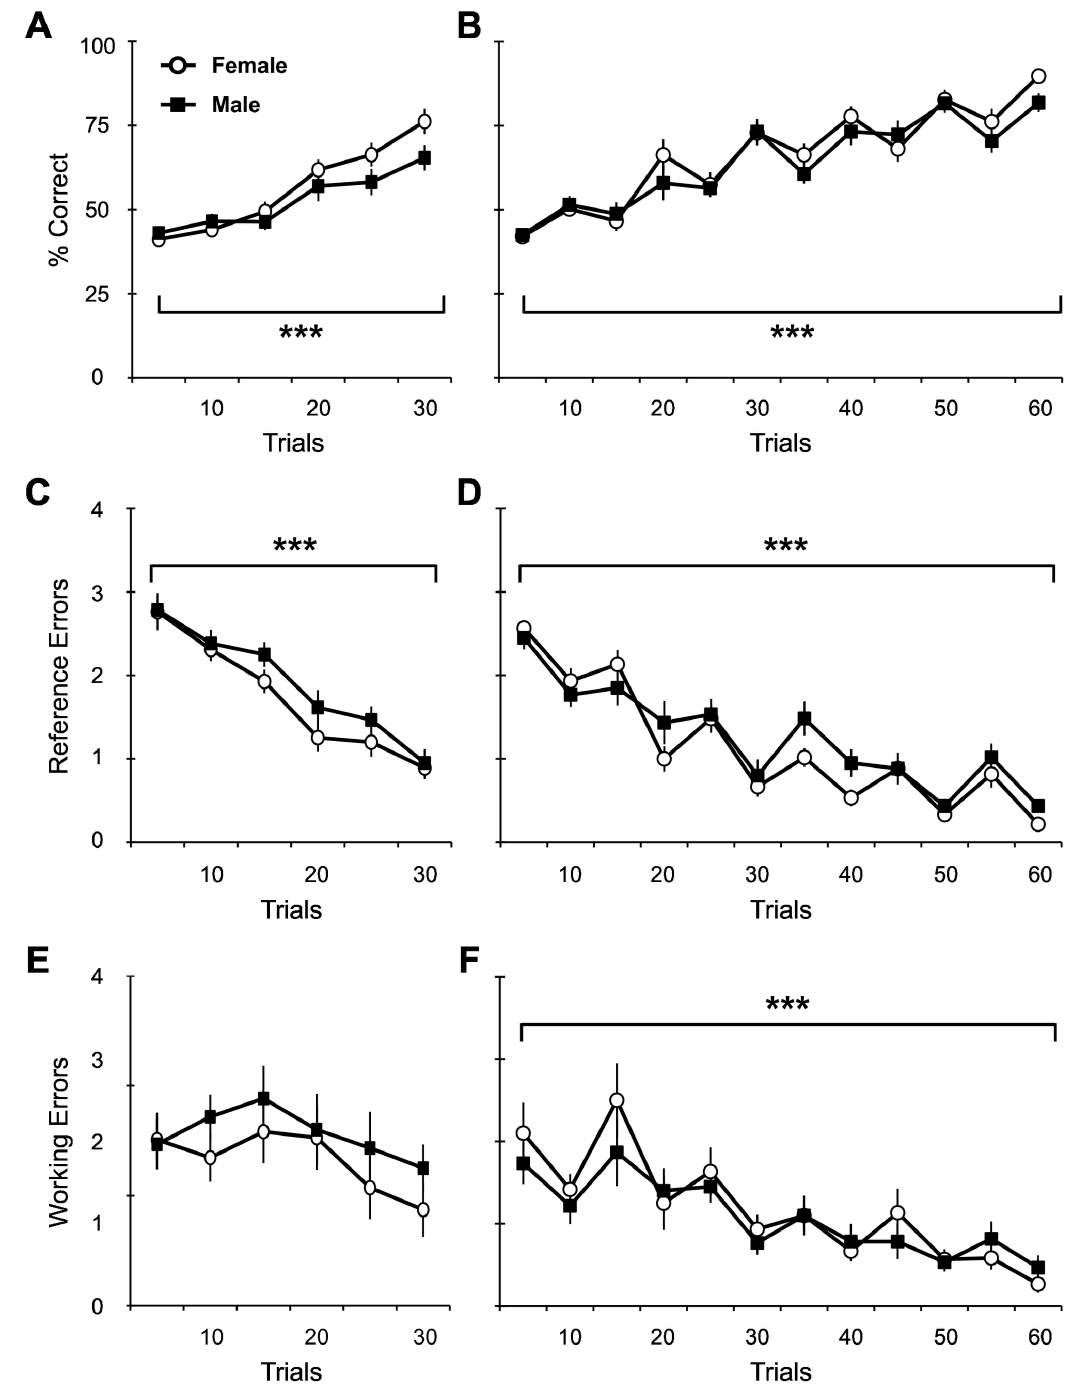
Figure 1. RAM training produced equivalent learning between sexes with either 30 or 60 training trials. (A, B) There was an overall significant improvement in percent correct over time and no significant differences with respect to sex in subjects given either 30 or 60 trials during training. However, the 60-trial cohorts achieve asymptotic performance during the last 2 days of training trials but the 30-trial cohorts do not. (C, D) The average number of reference memory errors per trial was significantly reduced over time with no sex effects in subjects given either 30 or 60 trials during training. (E, F) The average number of working memory errors per trial was significantly reduced over time only in subjects given 60 trials during training. There were no sex differences in either 30- or 60-trial cohorts. For all graphs, asterisk denotes significant effect over time (***p<0.001). doi: 10.1371/journal.pone.0081121.g001 PLOS ONE |